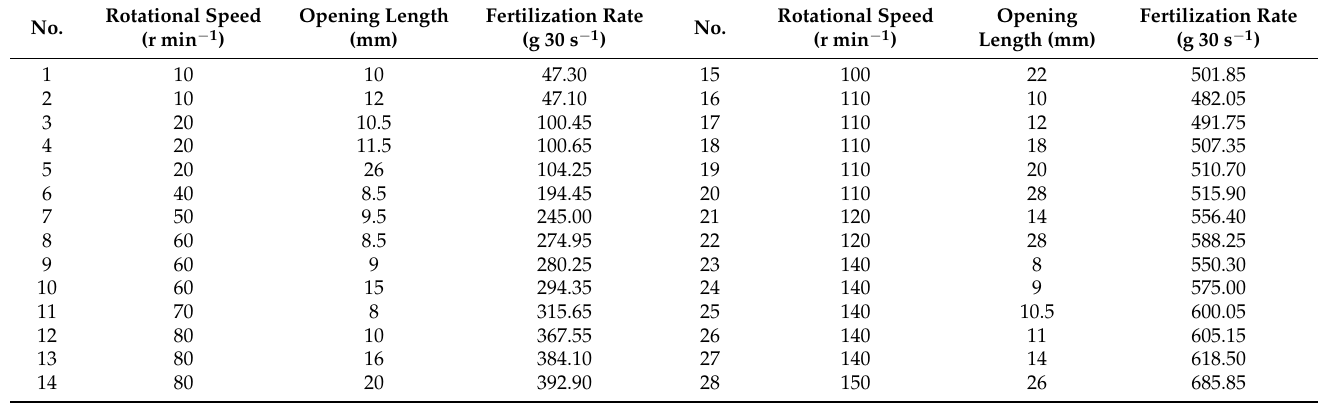
Table 6. Test samples of segment